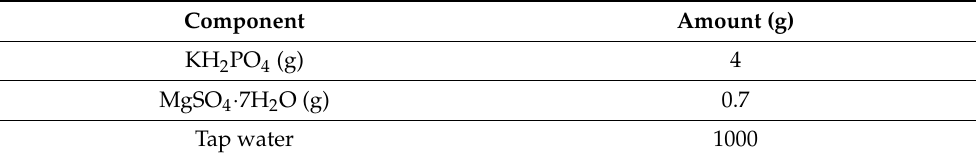
Table 1. Mineral basis of production media.